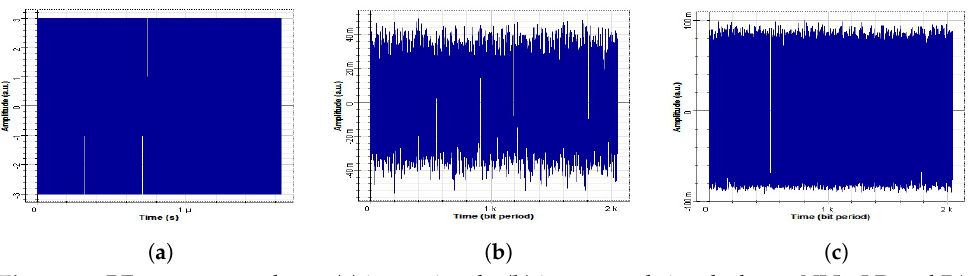
Figure 12. RF spectrum analyzer; ( a ) input signals, ( b ) interrupted signals due to NLIs, LD and PAPR of proposed model at length = 10 km, ( c ) output signals with compensated NLIs, LDs and PAPR of proposed model at length = 10